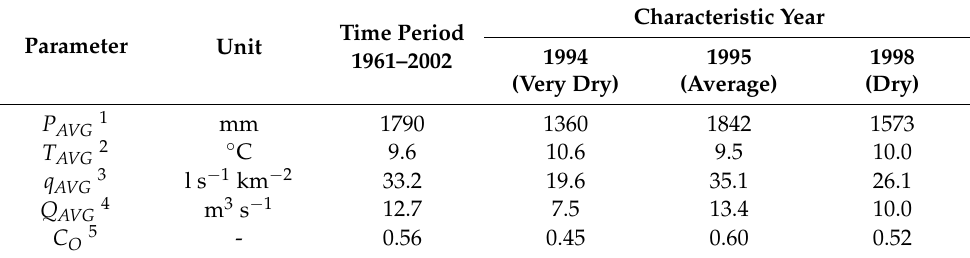
Table 1. Water balancing results in the Opatija springs catchment area.